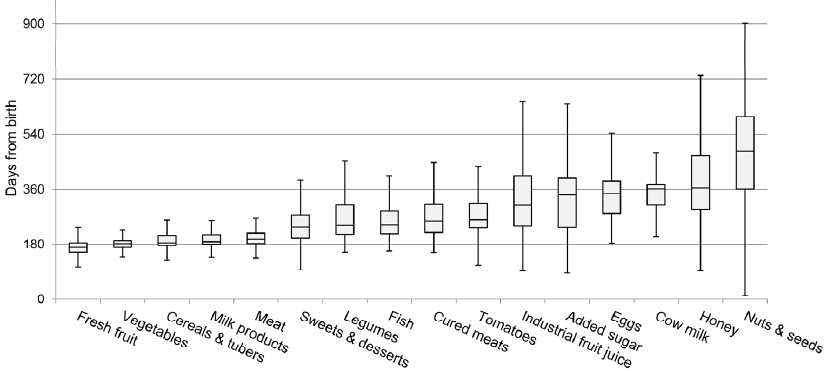
Figure 2. Timing of introduction of the single food groups in days from birth. The ends of the whiskers are set at 1.5*IQR above the third quartile (Q3) and 1.5*IQR below the first quartile (Q1). If the Minimum or Maximum values are outside this range, then they are shown as outliers. IQR =